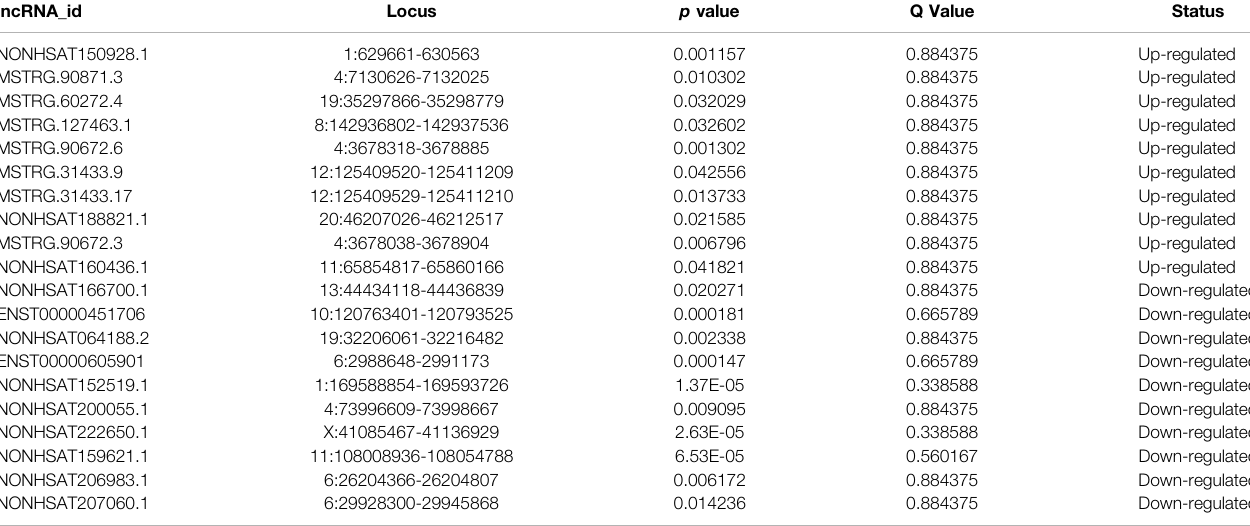
TABLE 2 | Top 10 signi fi cantly upregulated and downregulated lncRNA between groups.